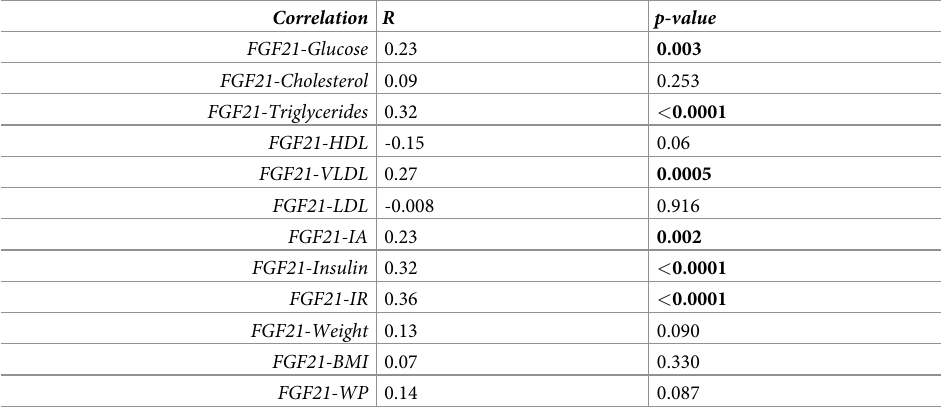
Table 3. Univariate analysis for FGF21 and biochemical parameters in PLWH.